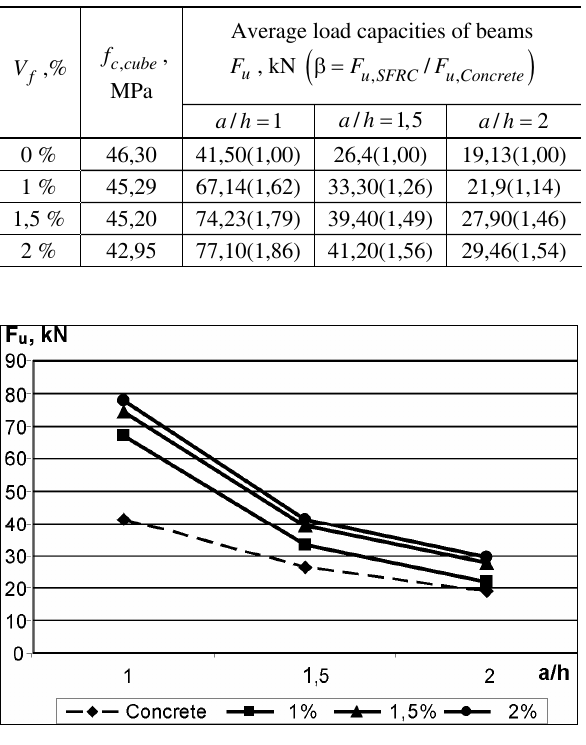
Fig 3. Influence of fibre volume / a h on load capacity of the tested beams